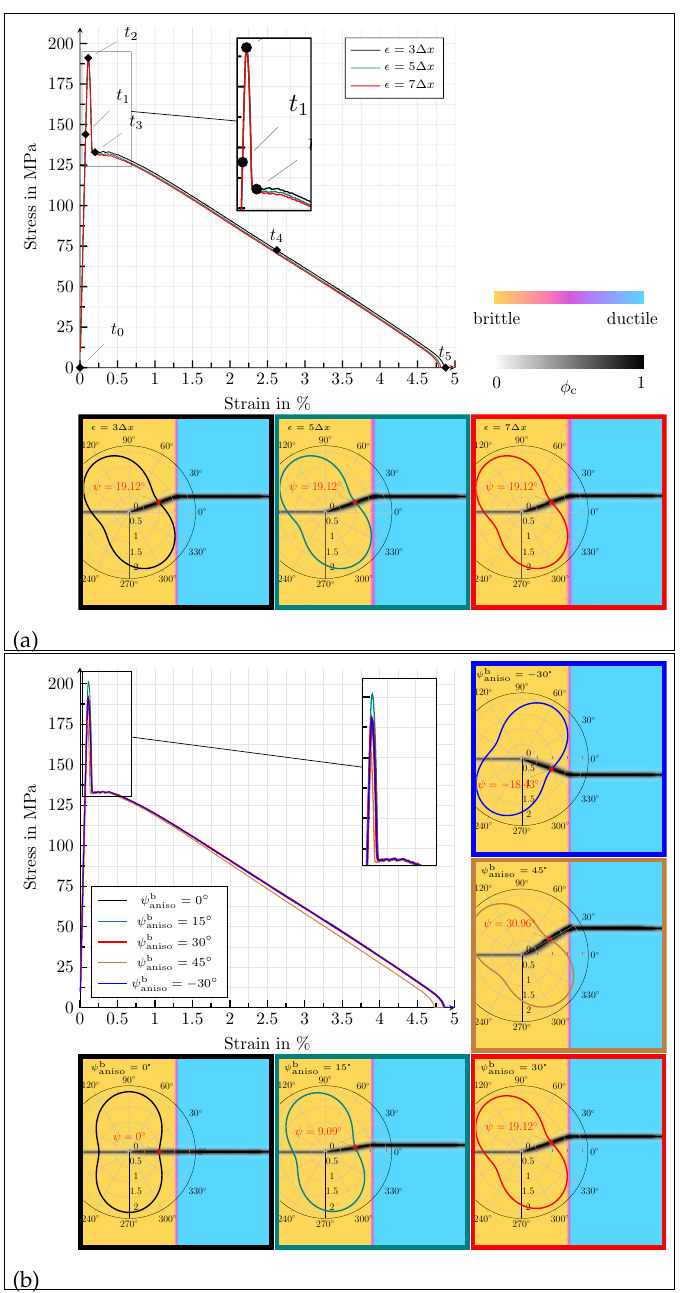
Figure 2. ( a ) Homogenised macroscopic stress–strain responses in the case of uniaxial tension for ∆ x , for the simulation setup with a planar diffuse interface between different values of (cid:101) = 3,5,7 { } two solid phases. The dots in the stress–strain diagram correspond to the strain states of the contour plots of Figure 3. Below the diagram, contour plots of the crack phase φ c at fracture are given, overlaying the solid phases for the various values of (cid:101) . ( b ) Homogenised macroscopic stress–strain = responses in the case of uniaxial tension for different values of ψ b 0,15,30,45, 30 °, for the aniso { − } simulation setup with a planar diffuse interface between two solid phases. The contour plots of the crack phase φ c at fracture, overlaying the solid phases, for the different values of ψ b are given aniso below and beneath the stress–strain